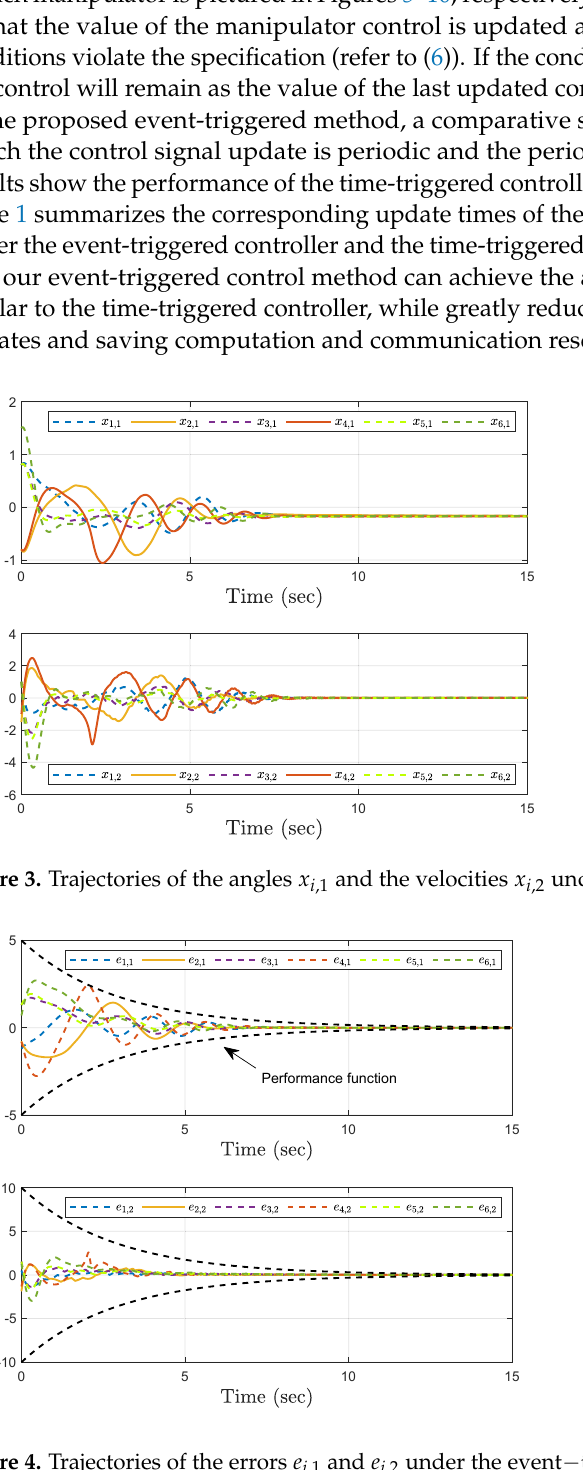
Figure 4. Trajectories of the errors e i ,1 and e i ,2 under the event − triggered